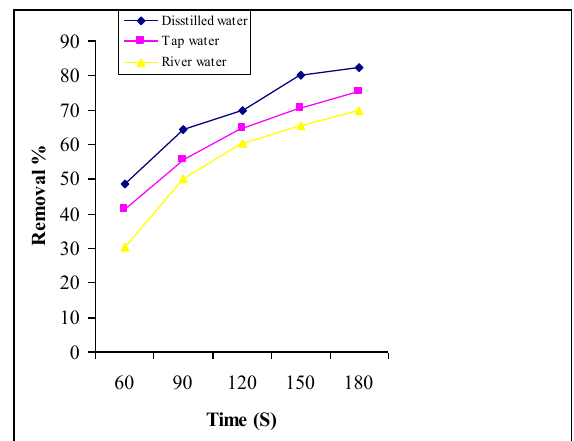
Figure 6 . Investigation the efficiency of UV/H